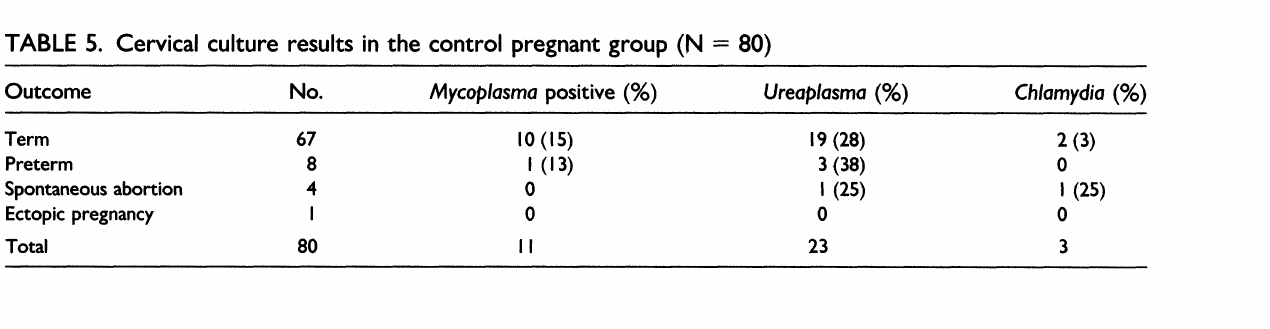
TABLE 5. Cervical culture results in the control pregnant group (N